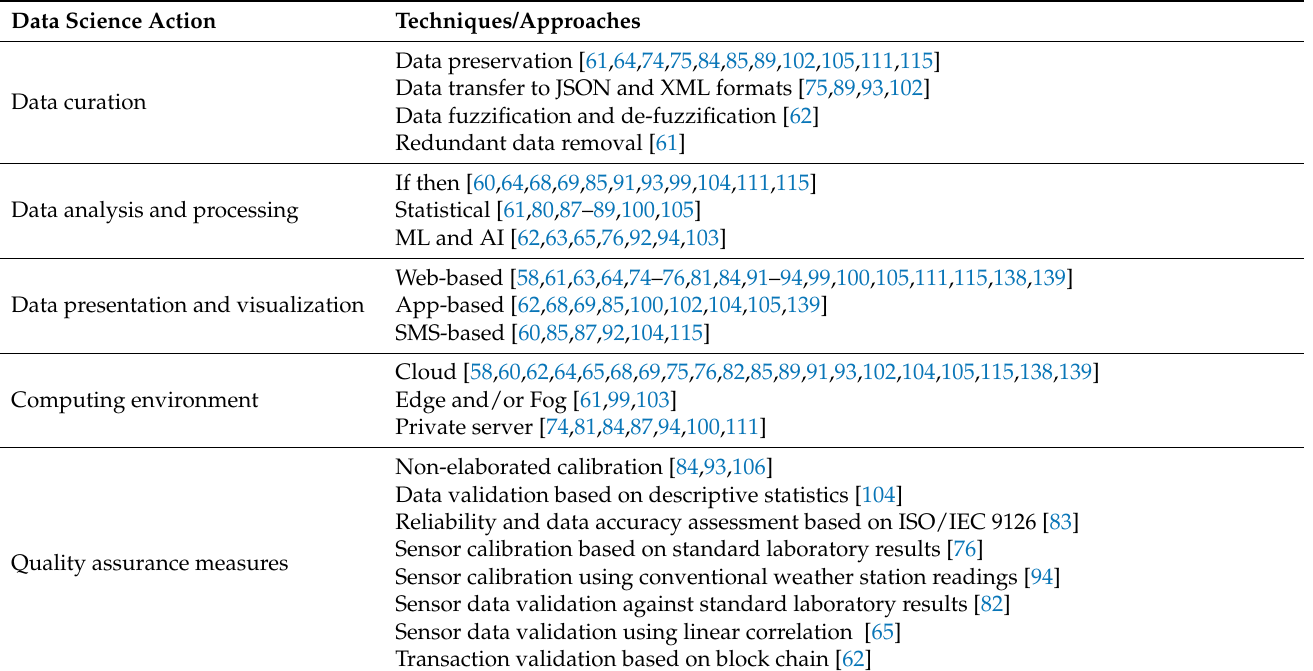
Table 3. Assessment report of reviewed works based on defined data science actions. Note that categorizations are not exclusive and some works utilized multiple classes of computing action. ISO/IEC 9126 describes software characteristics for quality